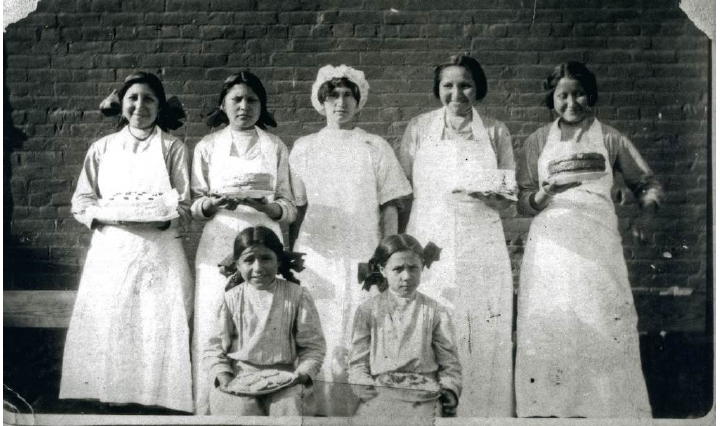
Figure 6. Rainy Mountain Pie Club, ca . 1915. Unknown photographer. Parker McKenzie Collection, Courtesy of the Oklahoma Historical